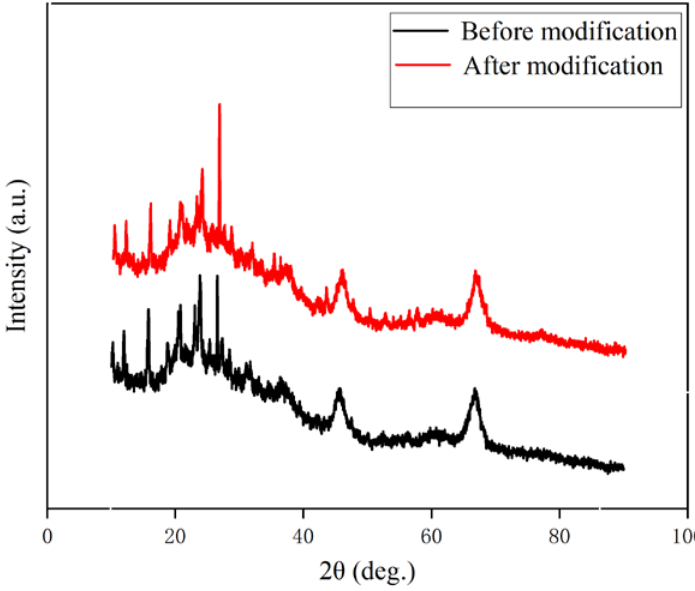
Figure 2. XRD spectrum of spent FCC catalyst.